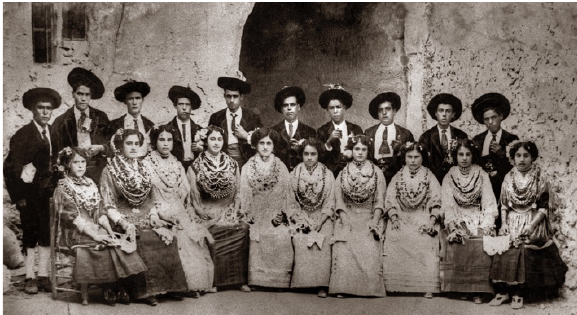
Figure 26. Kings and queens of the traditional dances in